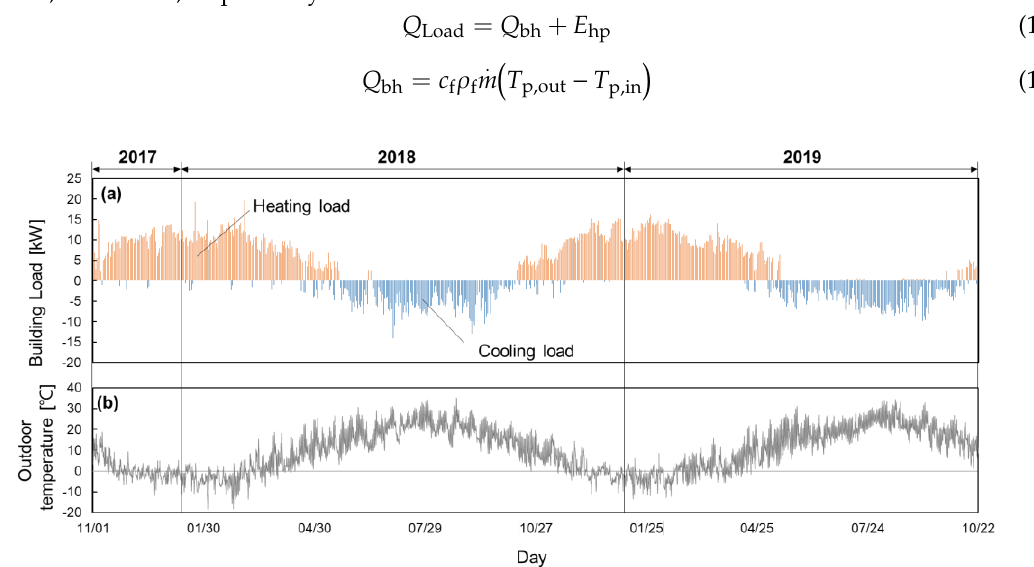
Figure13. Heatingandcoolingloadofthetargetbuilding; ( a )buildingloadand( b Figure 13. Heating and cooling load of the target building; ( a ) building load and ( b ) outdoor temperature.